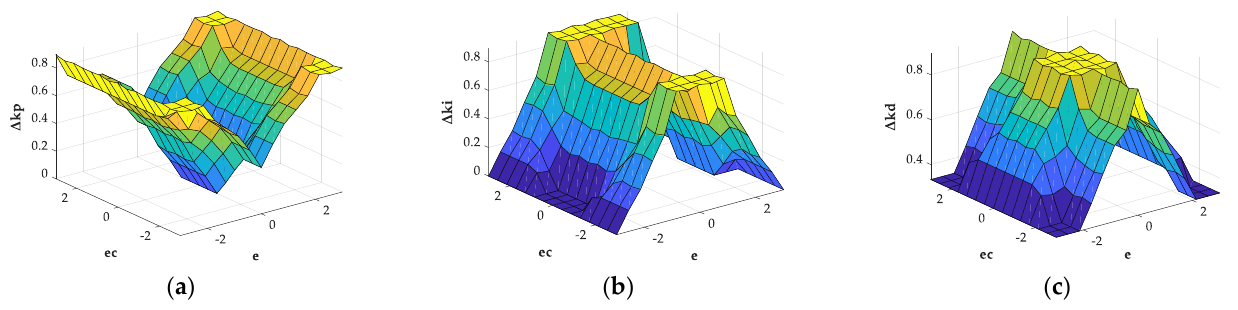
Figure 6. The output surface viewer of the fuzzy controller: ( a ) The fuzzy control surface of ∆ k p ; ( b ) The fuzzy control surface of ∆ k i ; ( c )The fuzzy control surface of ∆ k d .